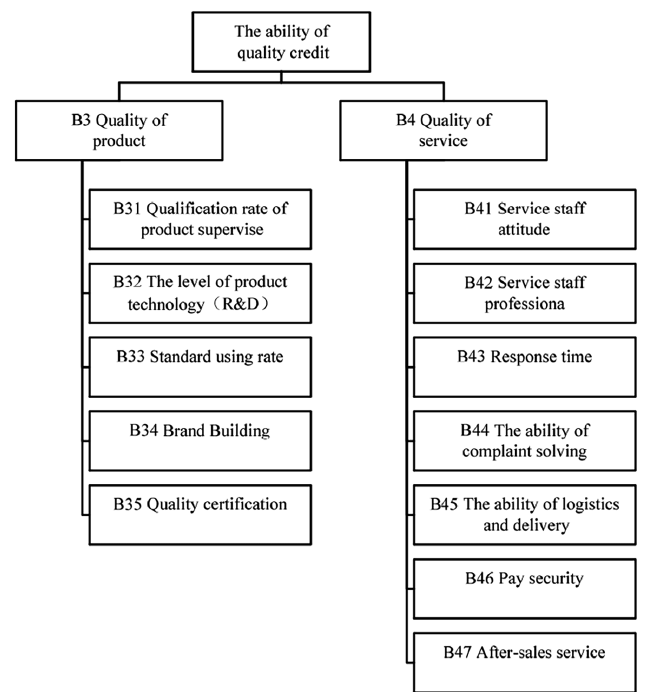
Figure 4. Hierarchy of quality credit